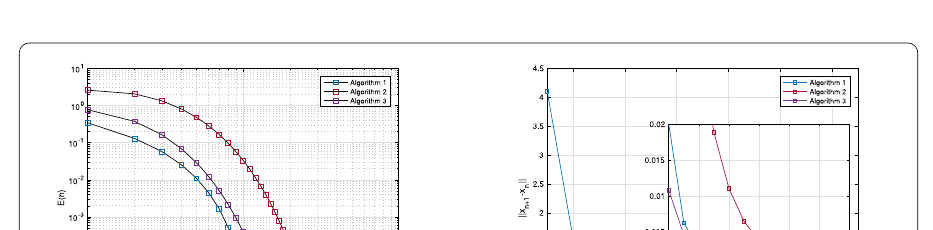
Figure 1 Computational results for Example 4.1 Case I